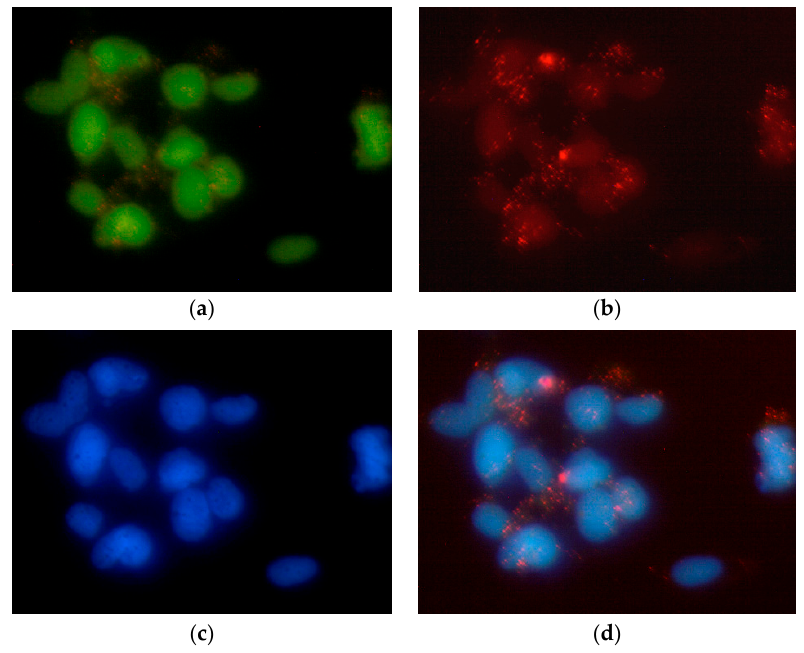
Figure 4. Fluorescence microscopy of HeLa cells after incubation with L–QD–TPT. Liposomes released the payload into the cell ( a : TPT; b : QD). Nuclei were stained with 4 ′ ,6-diamidino-2-phenylindole (DAPI) ( c ). The obtained images were merged into the same picture ( d ). All pictures are in 40× magnification.